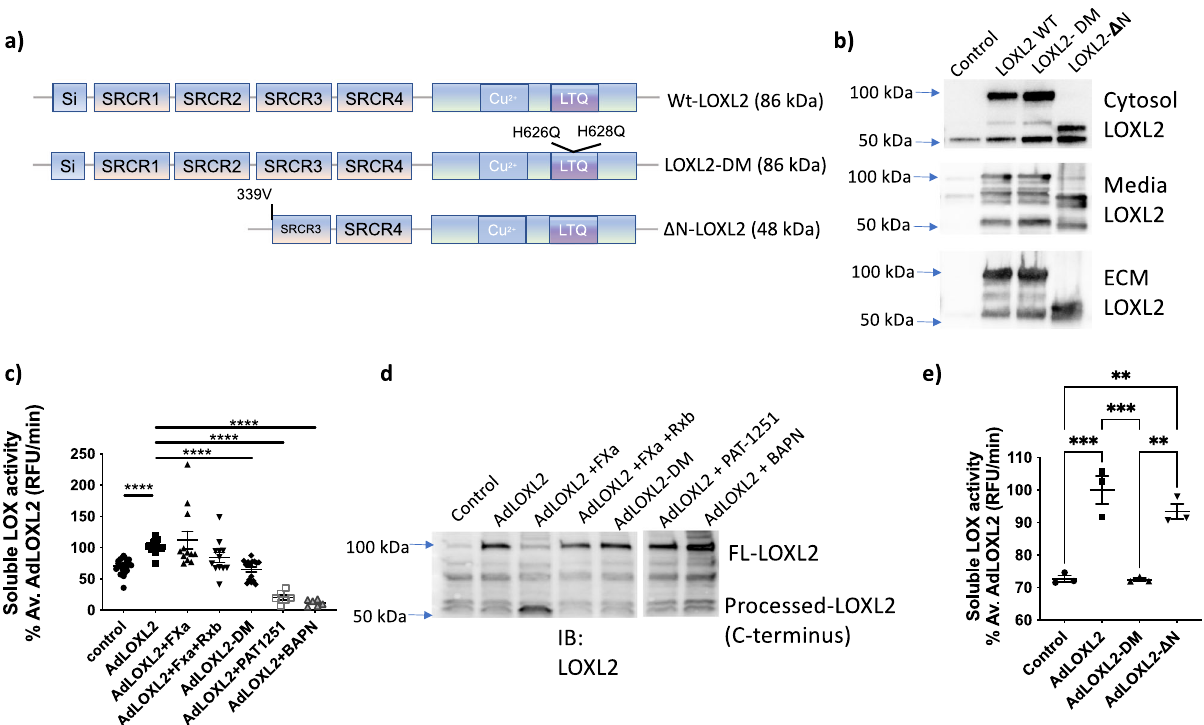
Fig. 5 Processing by FXa does not in fl uence the activity of soluble LOXL2. a Schematic of LOXL2 mutants used with predicted molecular weights in parenthesis and b representative Western blotting image of HEK293 cells overexpressing WT-LOXL2, LOXL2-DM, and Δ N-LOXL2 by transfection in the cytosol, conditioned media, and ECM. Equal amounts of protein were loaded for the cytosol, and a normalized volume of ECM and conditioned media proteins based on the cytosolic protein concentration were loaded on gels. c LOX activity in conditioned media measured by Amplite Fluorimetric LOX assay kit under indicated conditions. LOX activity was normalized to the average of AdLOXL2 condition. Data are shown as mean ± SEM ( n ≥ 6, **** P < 0.0001 by one-way ANOVA). d Representative Western blot of LOXL2 expression in the cell-culture media used for the Amplex Red activity assay. e LOX activity in the cytosolic fraction measured by Amplite Fluorimetric LOX assay kit under indicated conditions. LOX activity was normalized to the average of AdLOXL2 condition. Data are shown as mean ± SEM ( n = 3 ** p < 0.01, *** p < 0.001 by one-way